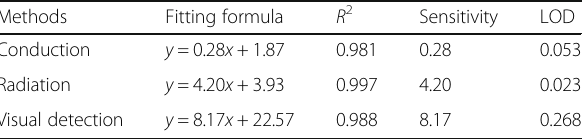
Table 2 The results of different methods in nanoparticle quantification